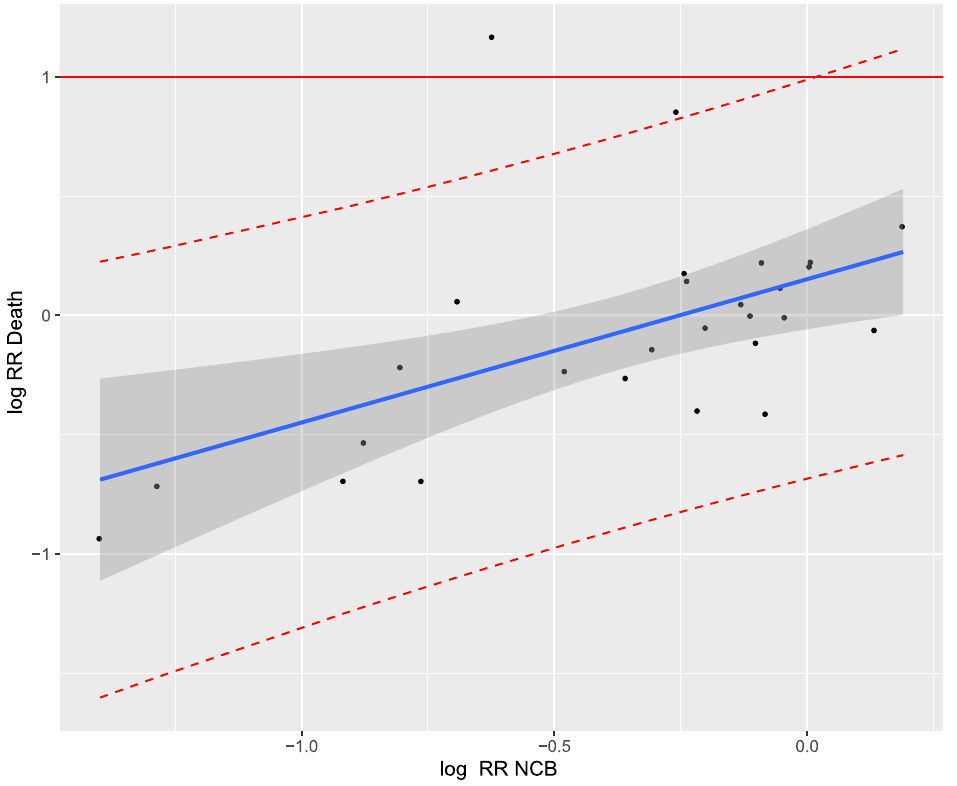
Figure 4. Trial-level association between treatment effects on net clinical benefit (NCB) and all-cause mortality in the treatment of acute venous thromboembolism. Cor = 0.24. The corresponding linear regression model was "Log RR Death = 0.6 × Log RR NCB + 0.15”. Each study is represented by a circle. A log scale was used for the x-axis and y-axis. The solid blue line represents the regression line and the grey area represents the 95% confidence interval. The red dashed lines represent the upper and lower limits of the 95% prediction interval. RR, relative